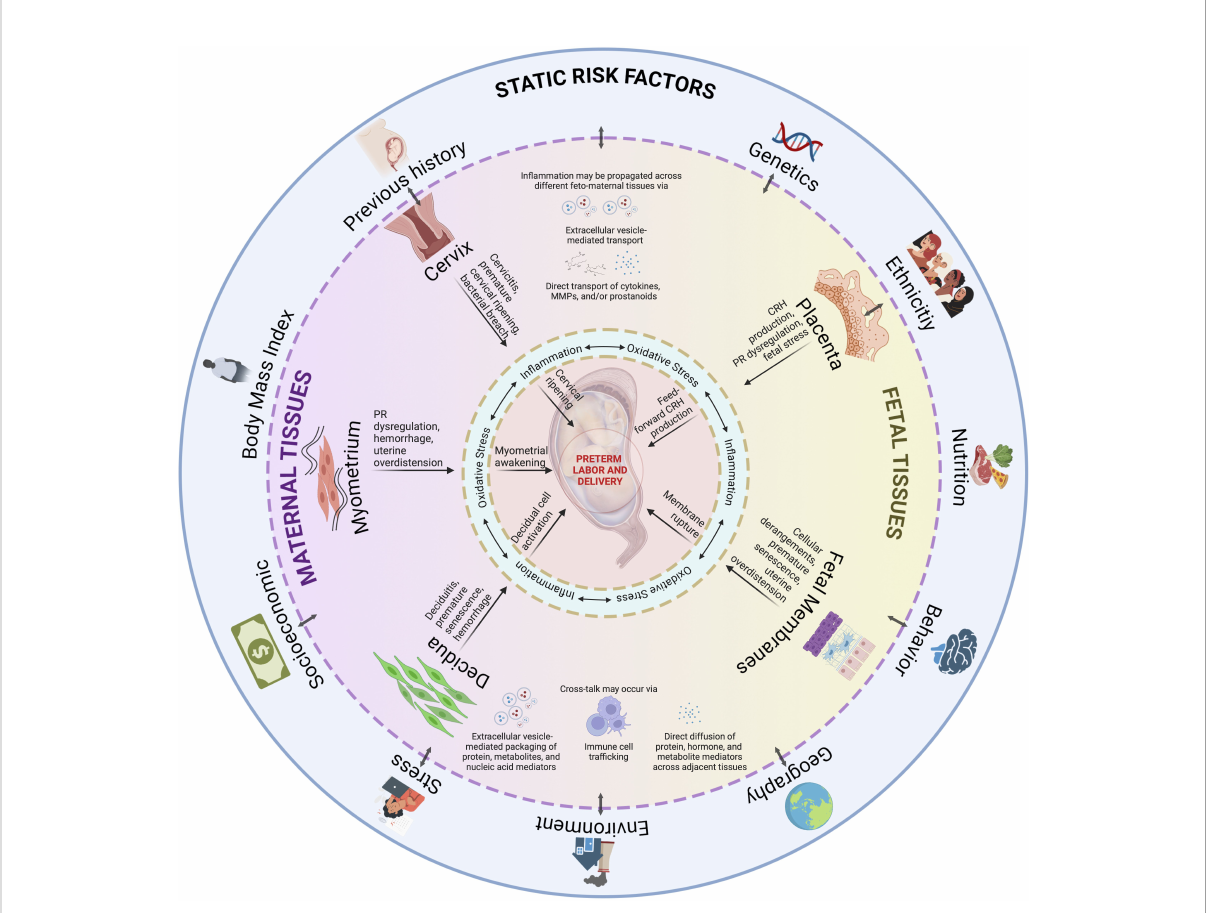
FIGURE 6 An integrated model for PTB. Static risk factors may provide susceptibility to inherited dysregulations in the fetal and maternal tissues. An interaction with ‘ pregnancy environment ’ can contribute to dynamic risk factors, such as those from acquired disease states as discussed per tissue subsection, may occur throughout the pregnancy. In fl ammation, and oxidative stress, provides the central tenet for PTB as they are inseparable in this process. As in fl ammation may propagate across different feto-maternal tissues, and tissue cross-talk may occur via various mechanisms, multiple contributions from affected tissues will eventually culminate to PTB. PTB is not a disease of a single system acting in silo but contributed by systems working together to produce an outcome. This fi gure was created with